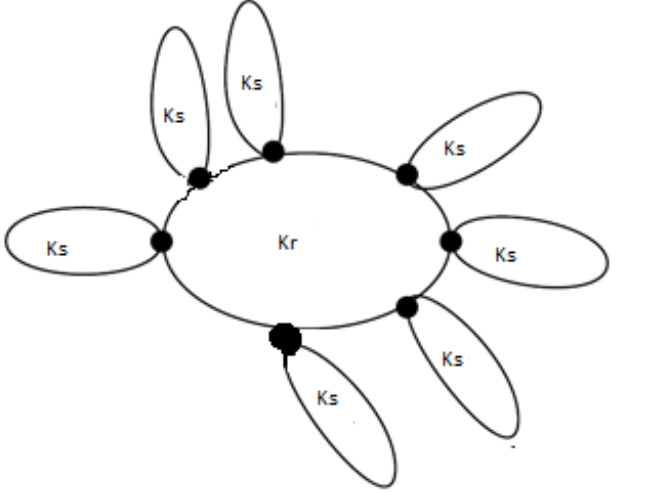
Figure 2. Cloud network graph C r,s .